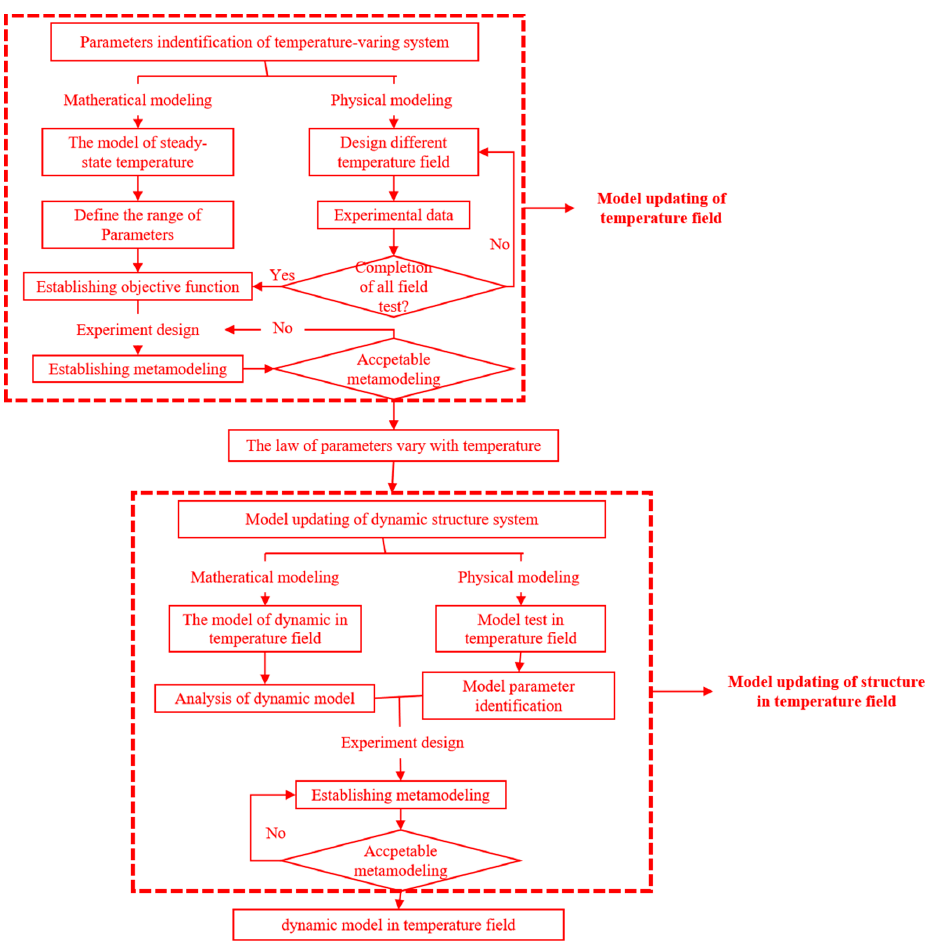
Figure 1. The flow chart of hierarchical correction.